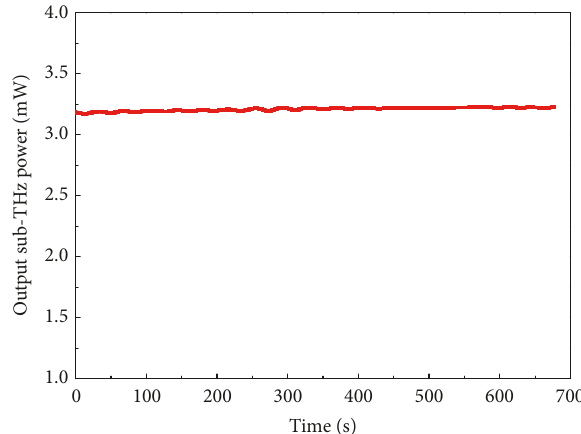
Figure 2: Power radiated from the antenna takes over 10 minutes with input optical power at 3.6